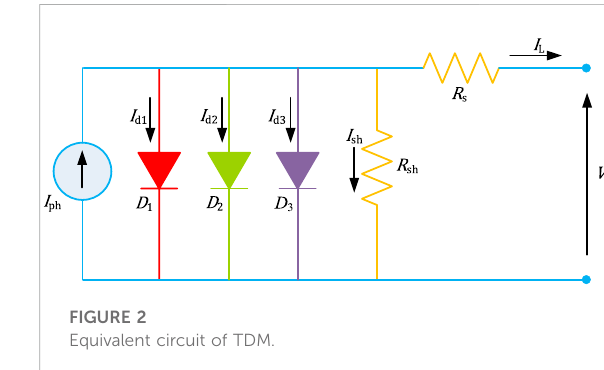
FIGURE 1 Equivalent circuit of DDM.